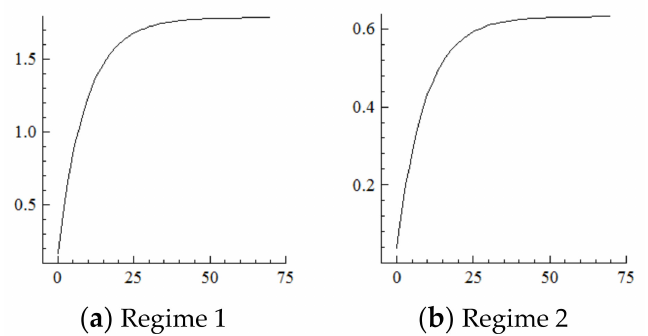
Figure 7. Cumulative Impulse Response of the Technological Level to Population Aging Shocks.